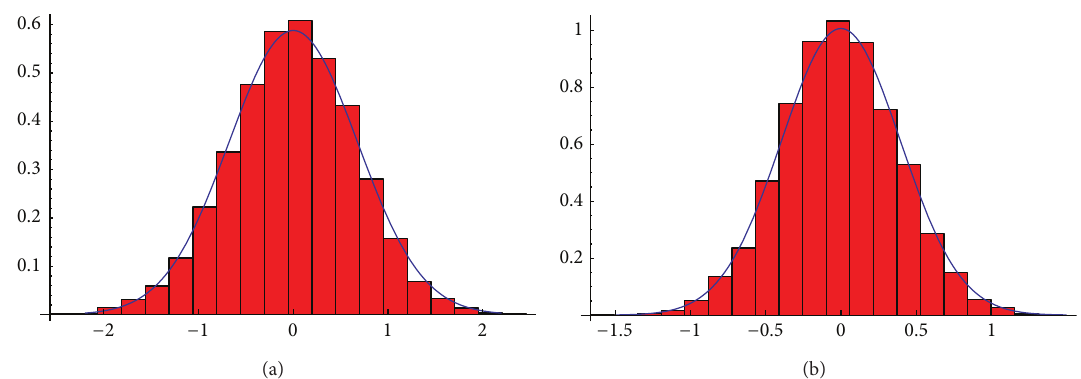
Figure 3: Histograms of the rescaled final proportions of (a) infected and (b) immunized individuals from 10000 simulations of the epidemic model in a population of size 1000 with immunization rate 𝜆 = 0.5 and limiting normal densities superimposed.